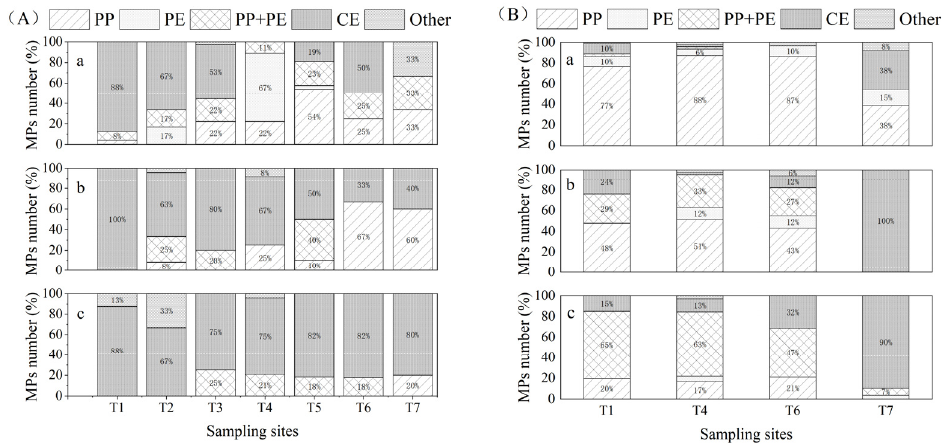
Figure 7. The proportion of microplastic components in different seasons. ( A ) denotes a water sample, while ( B ) represents a sediment sample. Proportions of various microplastic components in the wet, typhoon, and dry seasons are represented by a, b, and c, respectively.